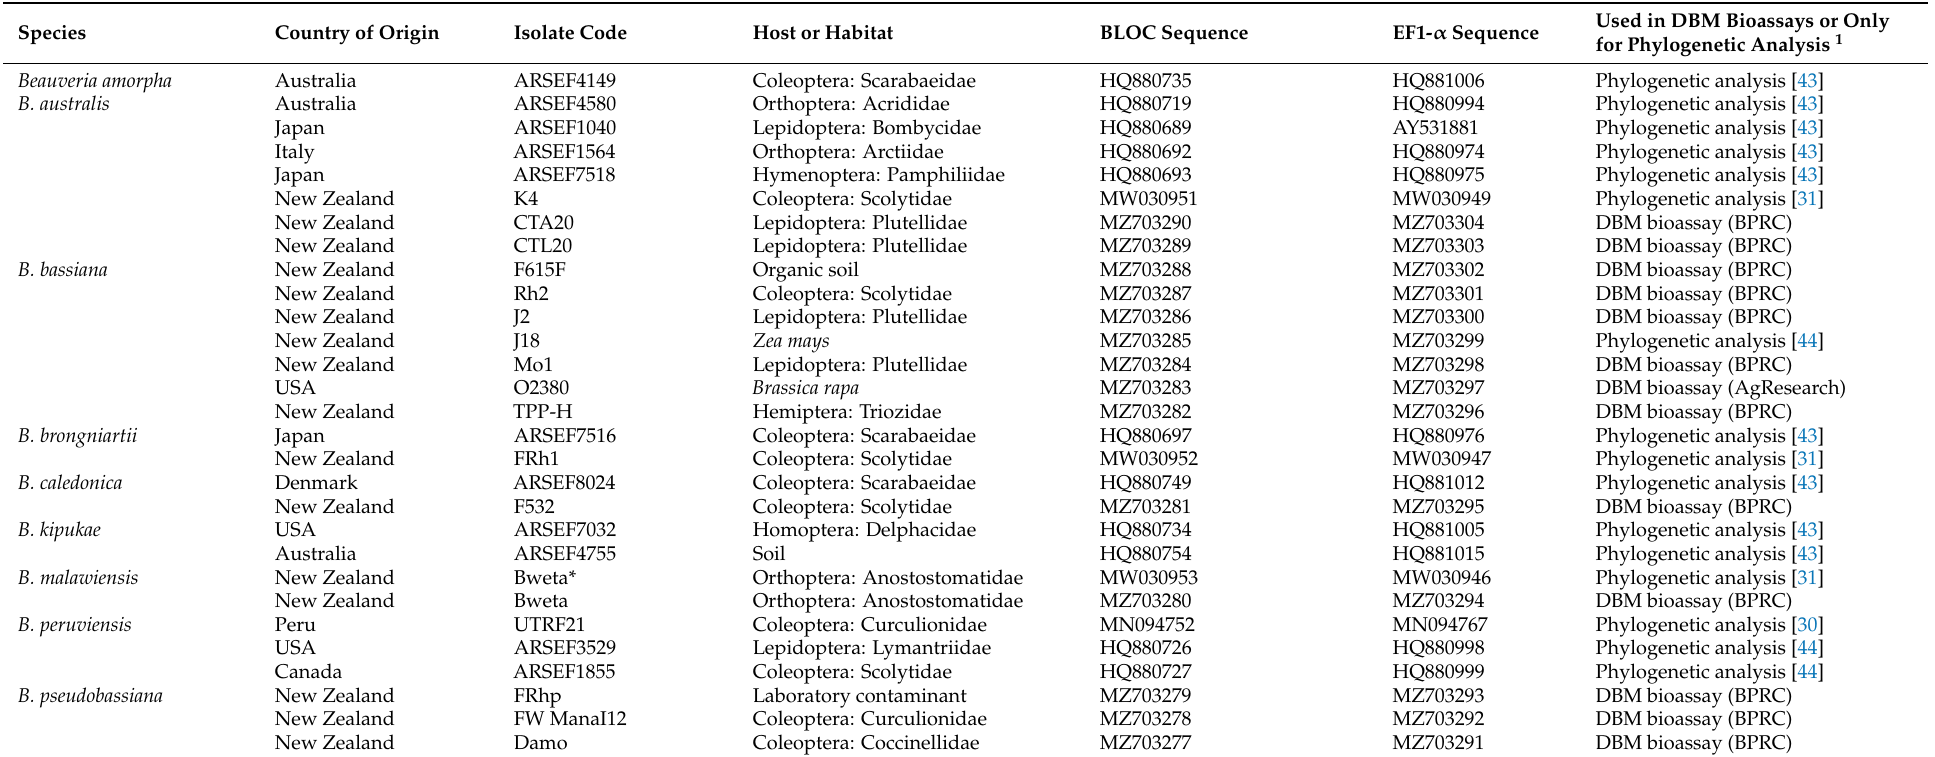
Table 1. A list of the Beauveria isolates including (1) those obtained from New Zealand collections assessed for the control of diamondback moth (DBM) and (2) those used for comparative purposes in the phylogenetic study. Host or Habitat BLOC Sequence EF1- α Sequence